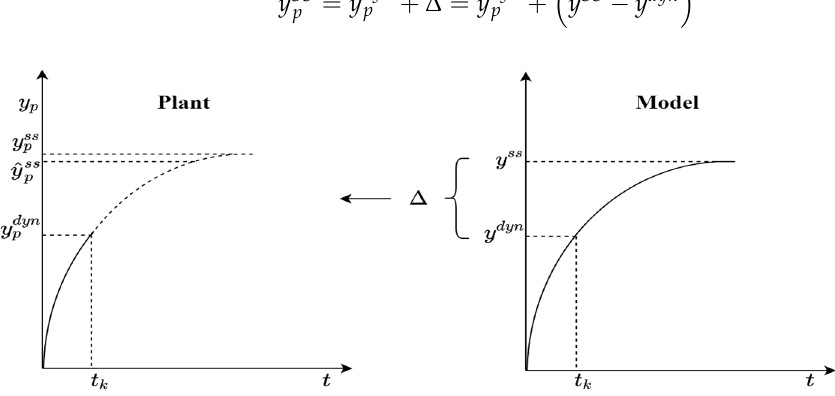
Figure 4. Estimation of plant steady state using measurements and a dynamic model.